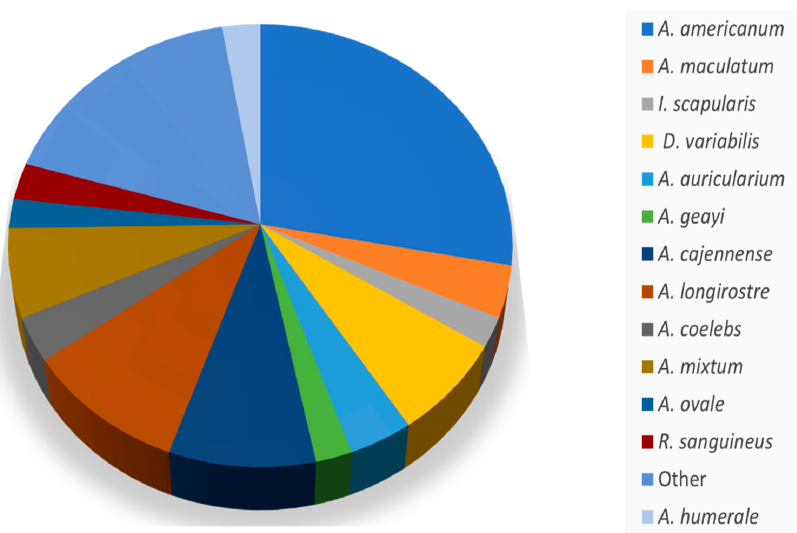
Figure 2. A pie graph of the species of tick reported infected with Rickettsia amblyommatis. The legend labeled as “other” included species that were only seen reported in 1–3 instances. These species were as follows: A. breviscutatum , A. calcaratum , A. dubitatum , A. hadanii , A. humerale , A. inornatum , A. neumanni